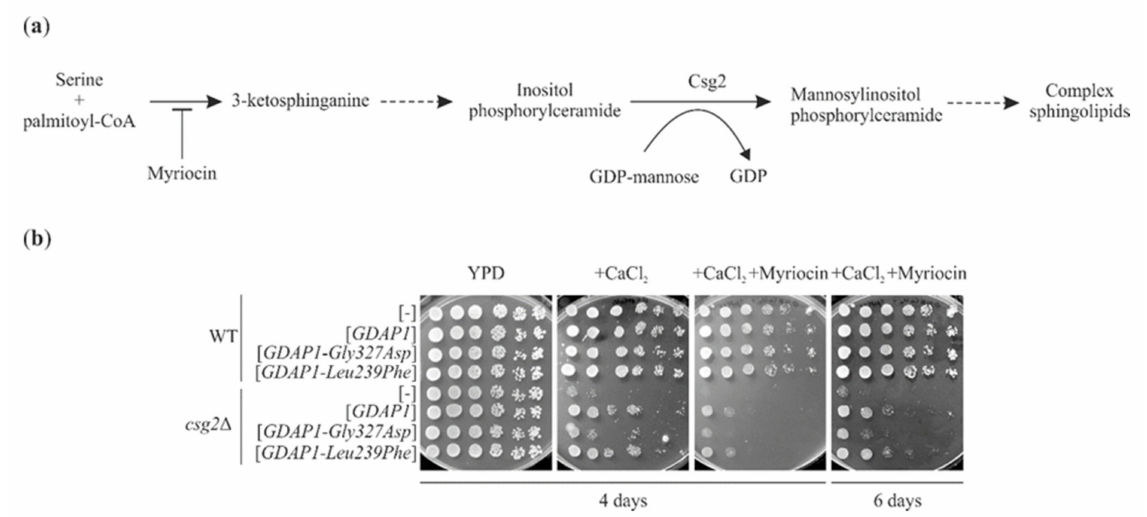
Figure 7. Expression of GDAP1 or the GDAP-Leu239Phe allele suppresses the sensitivity of the csg2 ∆ mutant to Ca 2+ ions even in the presence of myriocin. ( a ) Schematic representation of the sphingolipid biosynthesis pathway. The step inhibited by myriocin is indicated. (GDP) guanosine diphosphate. ( b ) The growth of wild-type and csg2 ∆ mutant strains transformed with empty vector ([-]), or vectors carrying the cDNA of GDAP1 , ([ GDAP1 ]) or GDAP1 variants ([ GDAP1-Gly327Asp ] and [ GDAP1-Leu239Phe ]) was compared on YPD media or YPD containing 0.4 M calcium chloride (+CaCl 2 ) or 0.4 M CaCl 2 and 1 µ M myriocin (+CaCl 2 +